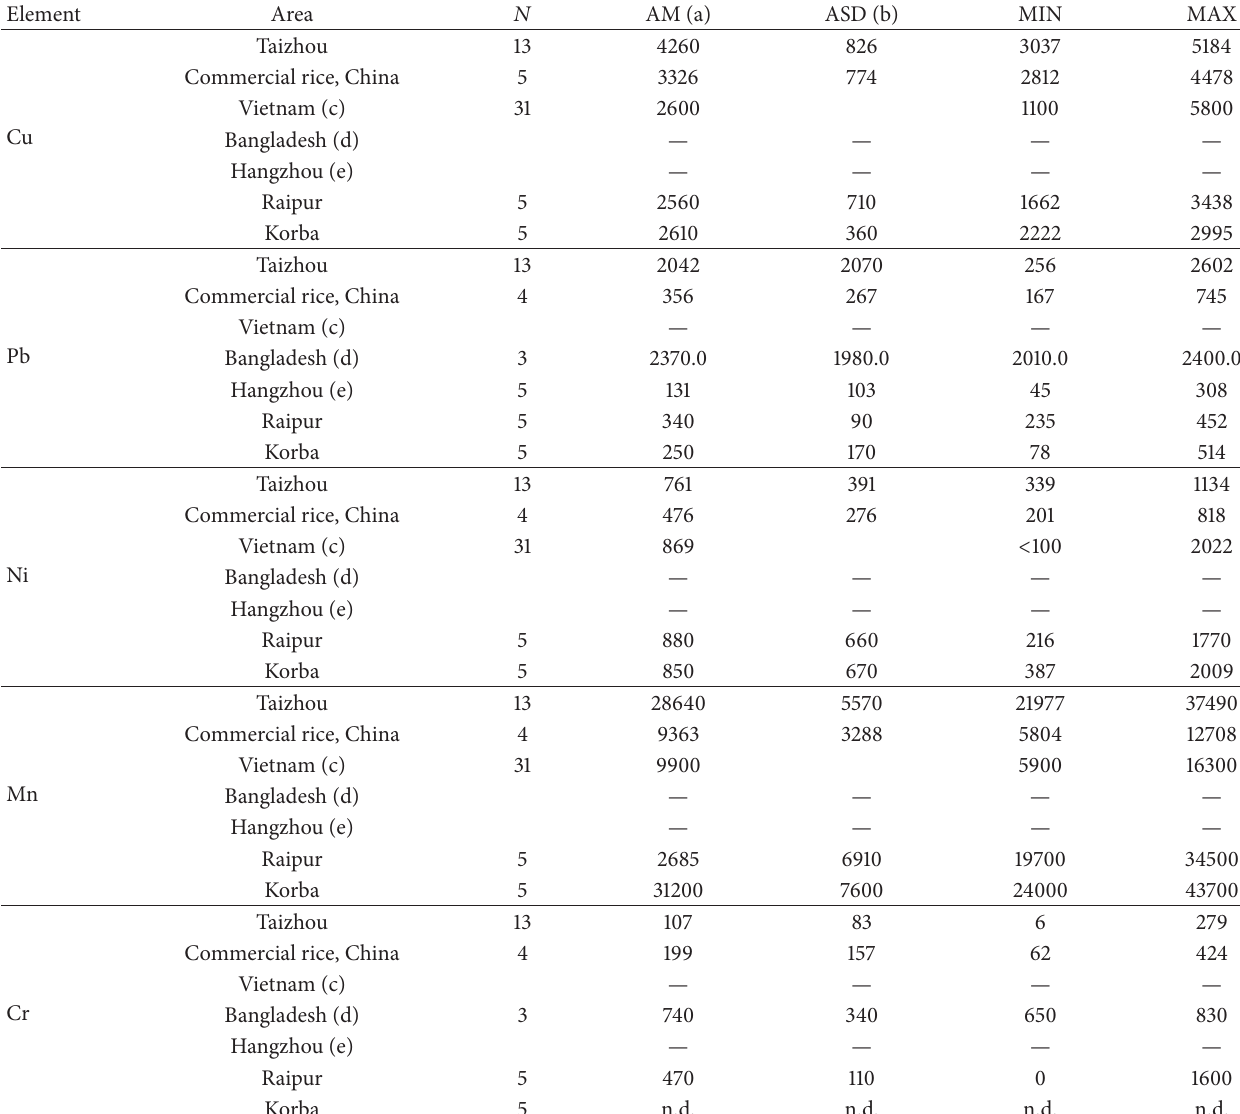
Table 7: Concentration of hazardous elements in rice samples reported in different literature studies: (a) arithmetic means; (b) arithmetic standard deviations; (c) [34]; (d) [35]; and (e) [36].